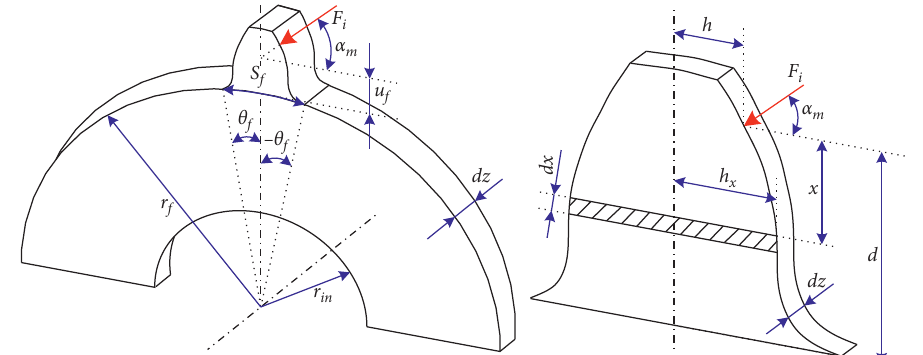
Figure 5: Sliced gear model and force